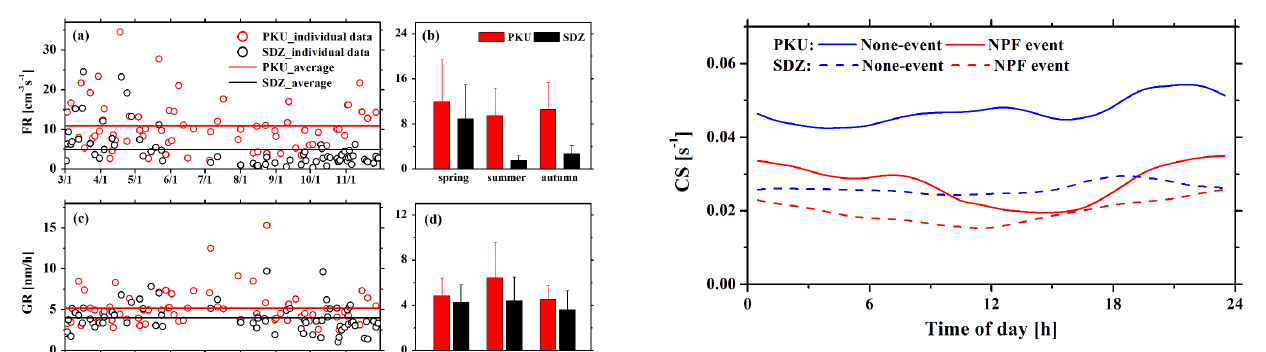
Figure 3. Diurnal variations of condensation sink ( CS ) on NPF event (red) and none-event (blue) at PKU (solid 844 Fig. 3. Diurnal variations of condensation sink (CS) in the NPF line) and SDZ (dash line). 845 event (red) and non-event (blue) at PKU (solid line) and SDZ (dash